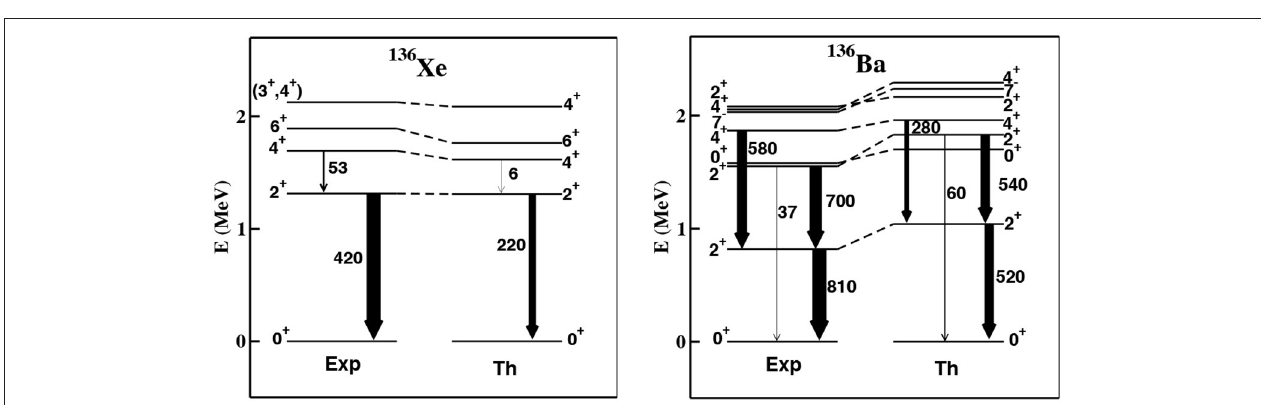
FIGURE 12 | Experimental and calculated spectra of 130 Te and 130 Xe; the arrows are proportional to the B ( E 2) strengths, whose values are reported in e 2 fm 4 . Reproduced from reference [102].